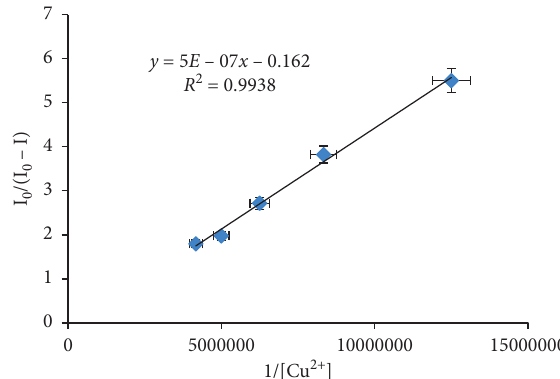
Figure 6: The change in I complex stability constant.